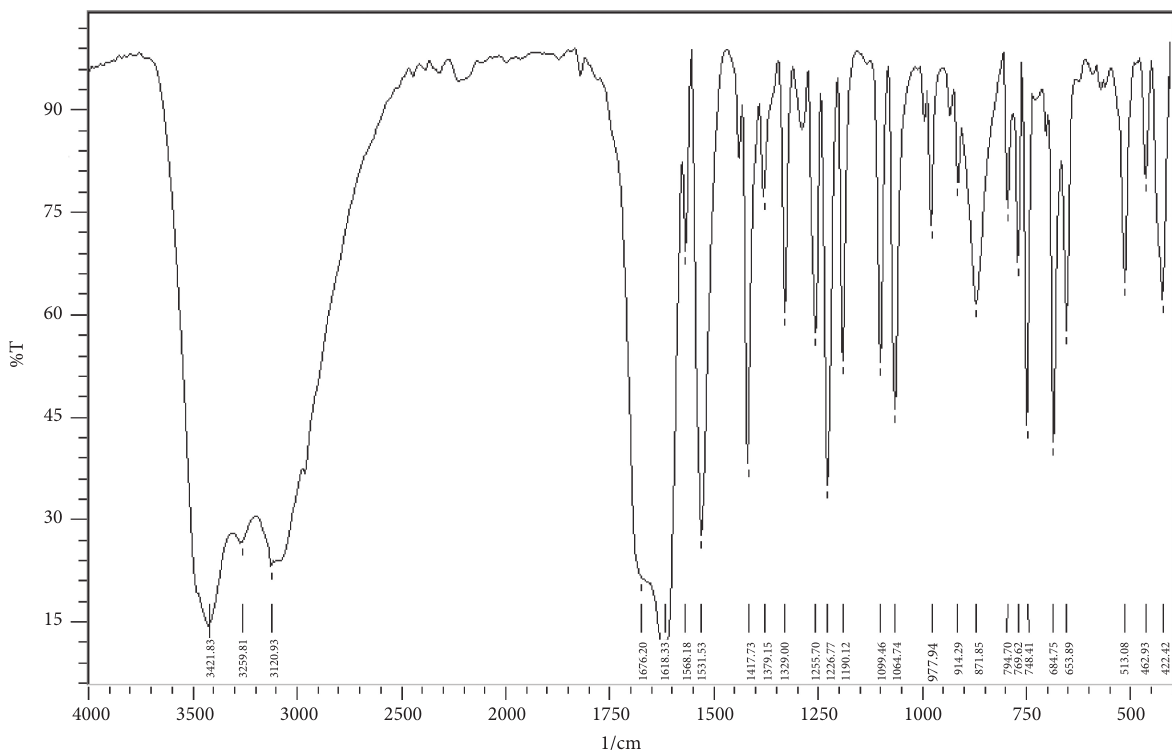
Figure 10: Infrared spectrum of nickel complex as KBr disk.